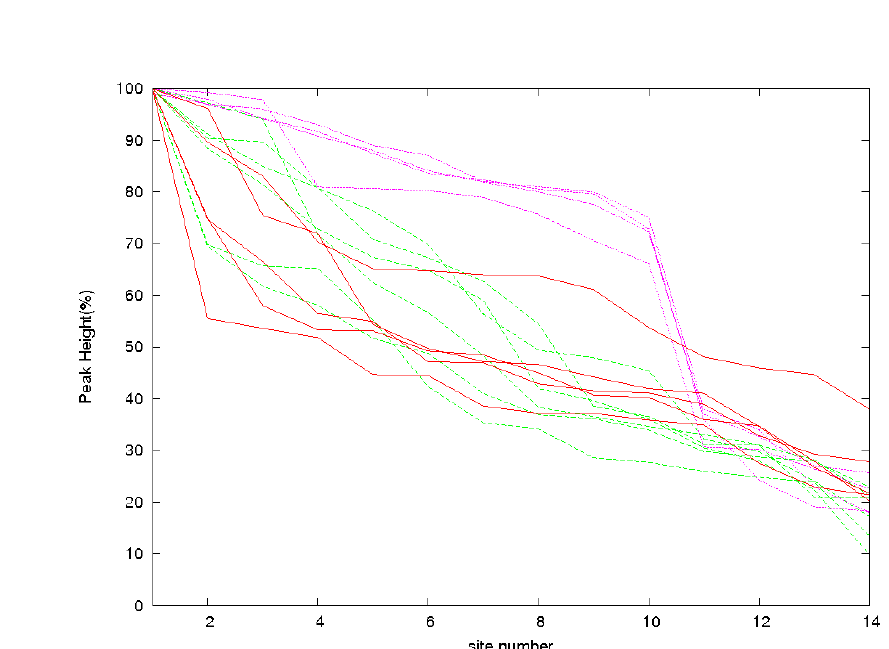
Figure 2. Site peak heights as a percentage of the top peak for Z-DNA calculated by SHELXD for a range of tries by the CCall value. The top tries, CCall > 40.00, are shown in purple. Other successful tries, CCall < 40.00, are in green, and unsuccessful tries are shown in red.